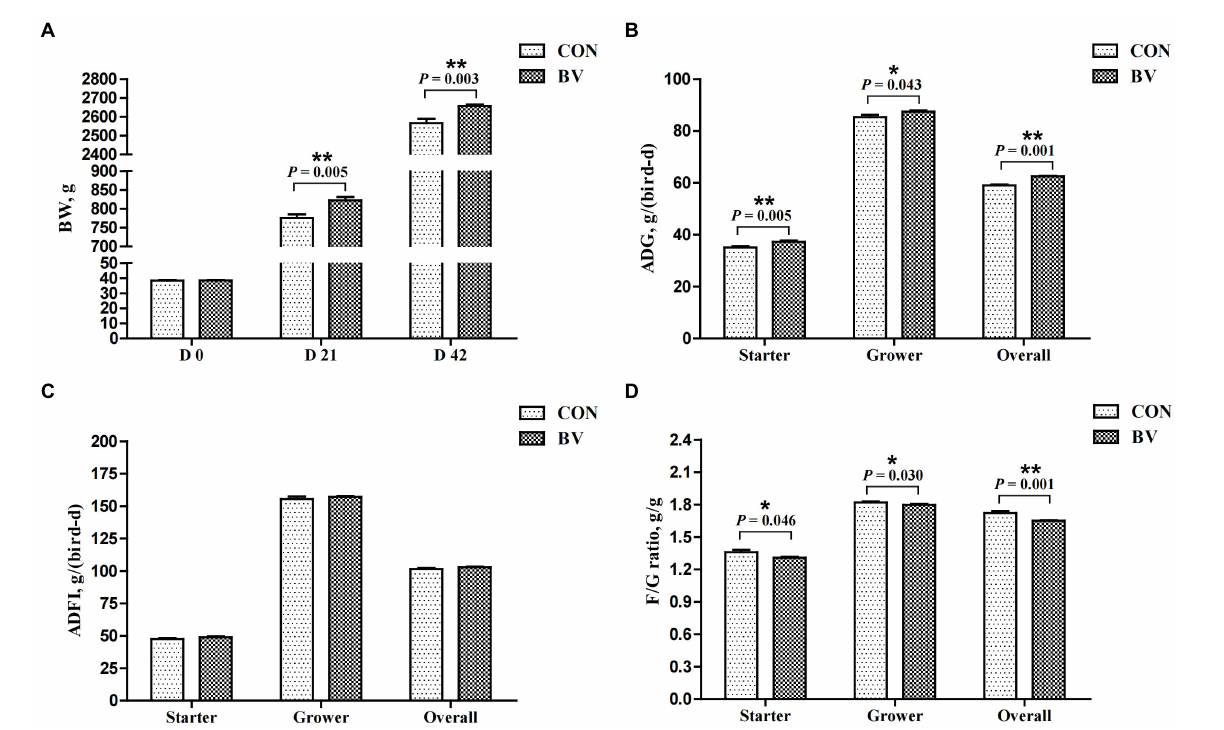
FIGURE 4 Effect of Bacillus velezensis LB-Y-1 on growth performance of broilers ( n = 6). CON = control group, broilers were fed a corn-soybean basal diet, BV = B. velezensis LB-Y-1 group, broilers were fed a basal diet containing 3.5 × 10 9 CFU/kg LB-Y-1. BW, body weight; ADG, average daily gain; ADFI,